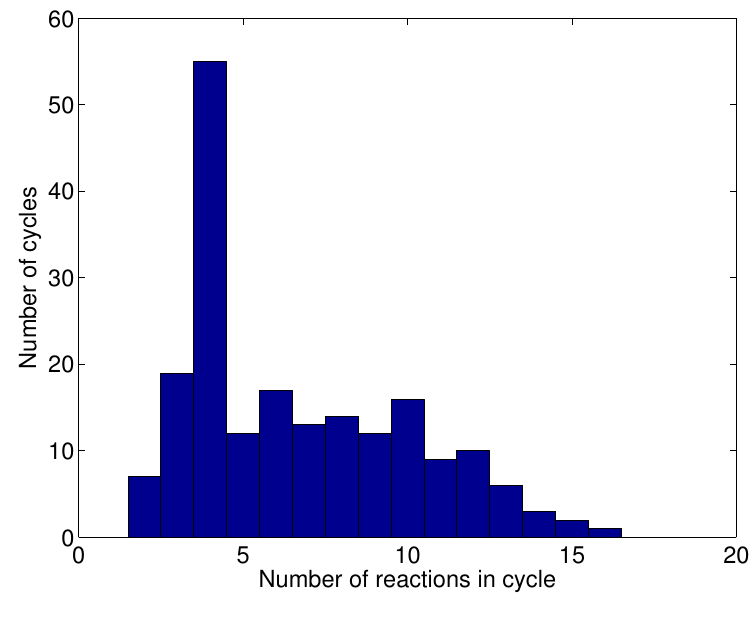
Figure 4. Histogram of the length (number of reactions involved) of the 196 independent cycles detected in E. Coli